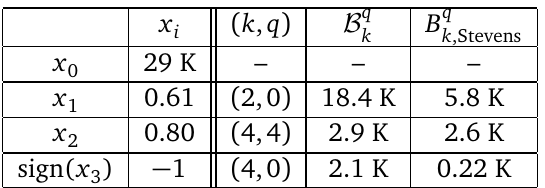
obtained from CNN using input experi- 2 ( T ) } for directions , χ α ( T ) , c M , T = 20K , B q and B q are defined i k k ,Stevens